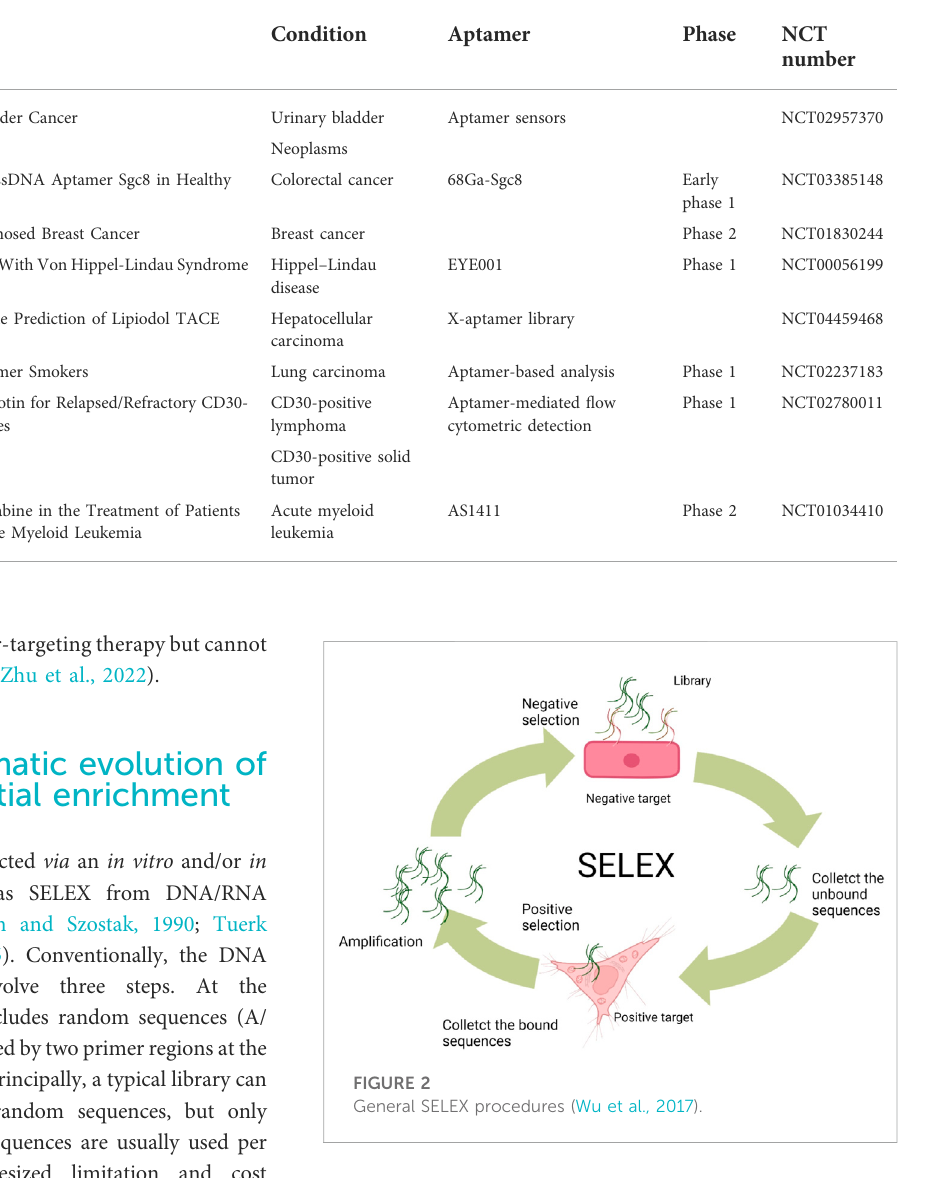
TABLE 1 Aptamer studies in cancer clinical trials.